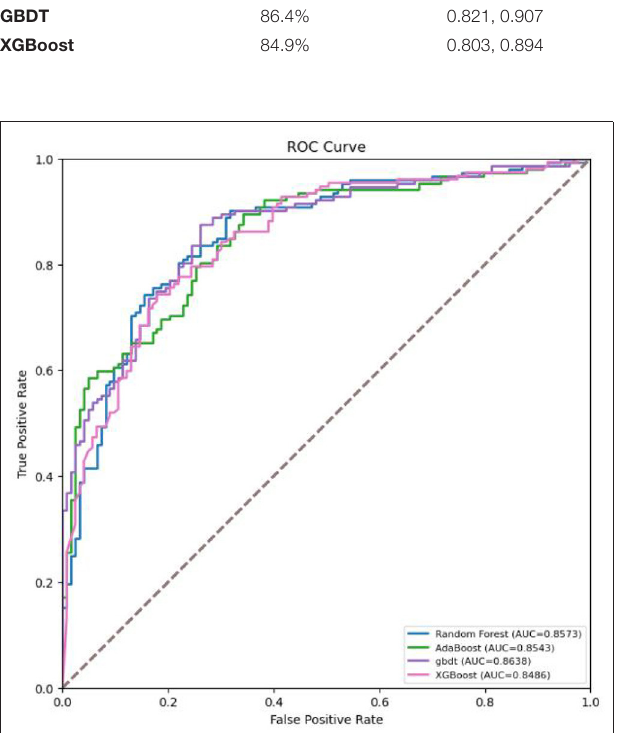
FIGURE 3 | Calibration curve for the internal validation set. The calibration curve was plotted using the bucket method (continuous data discretization) to observe whether the prediction probability of the classification model is close to the empirical probability (that is, the real probability). Ideally, the calibration curve lies along the diagonal (i.e., the prediction probability is equal to the empirical